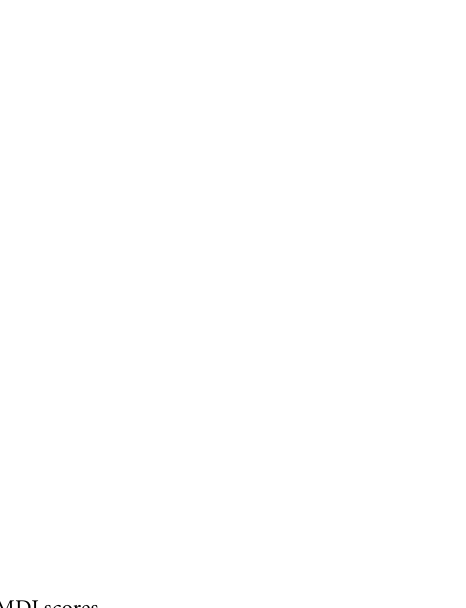
Table 3. Top-ranked features used by RF classifiers, using MDI